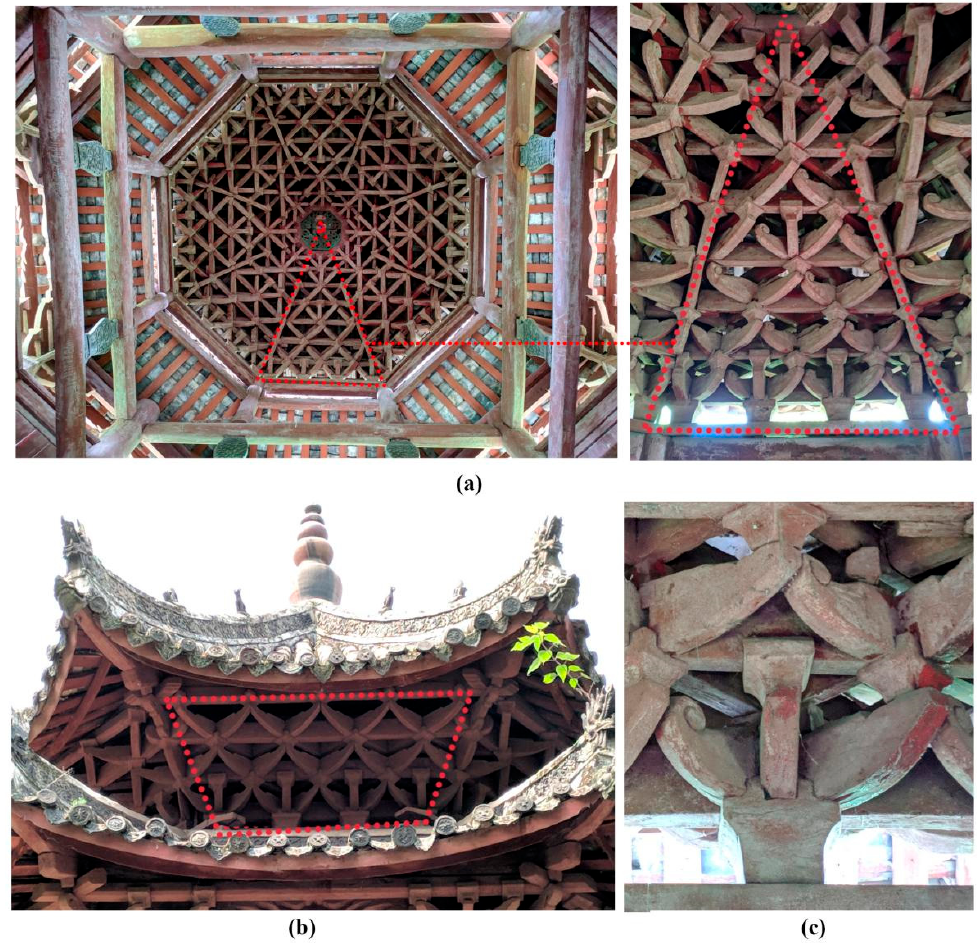
Figure 4. One side of Octagonal Xiegong on the third eave. ( a ) Xiegong on the third eave from inside and detail of one side; ( b ) Xiegong on the third eave from outside; ( c ) detailed of a bracket set.